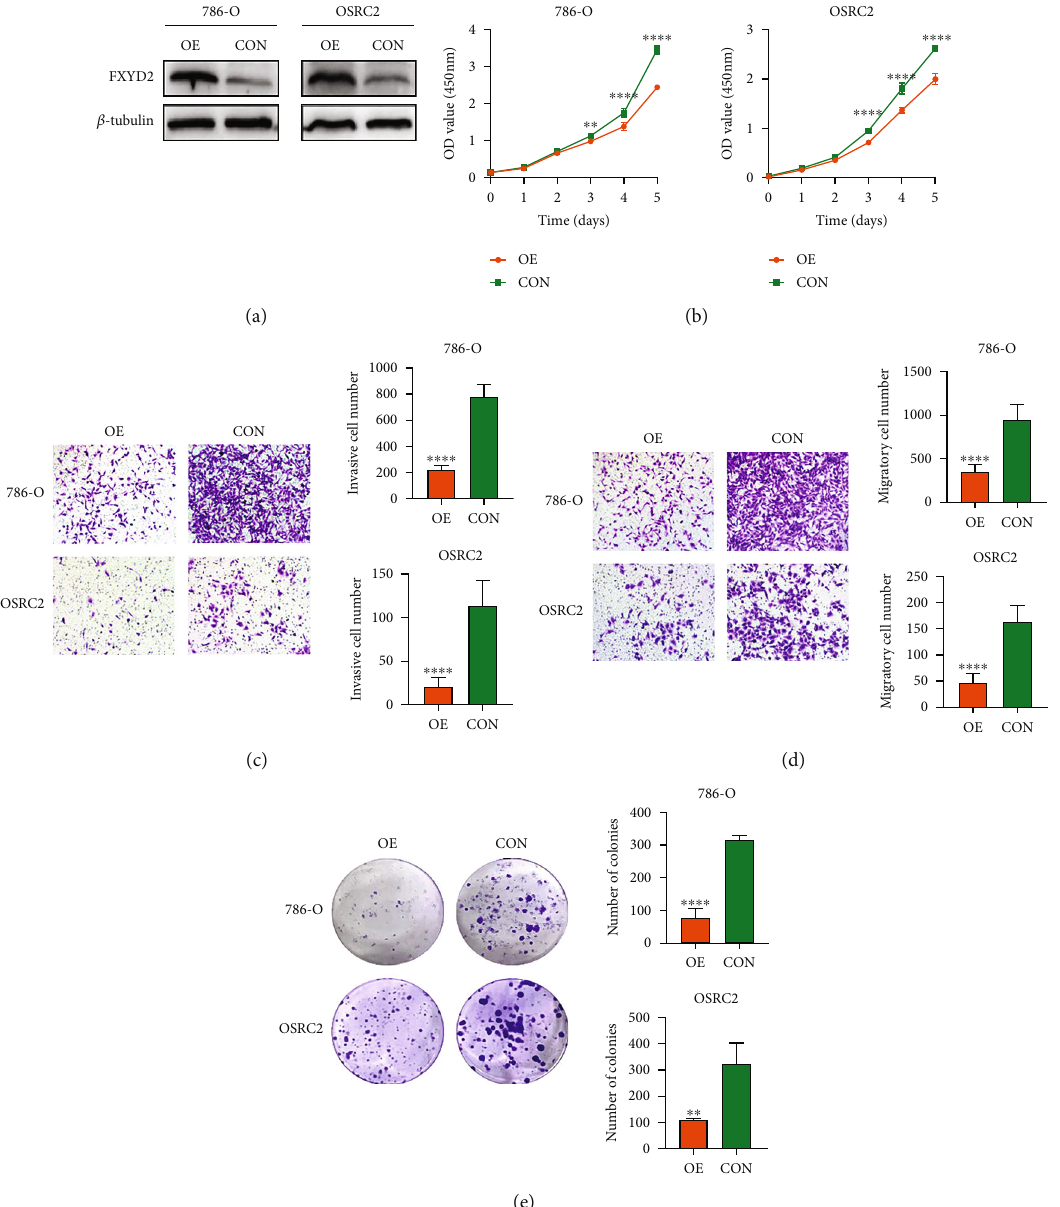
Figure 7: Overexpression of FXYD2 protein suppresses ccRCC cell proliferation, migration, and invasion in vitro. (a) The e ffi ciency of FXYD2 protein overexpression was determined by WB in 786-O and OSRC2 cells. (b – e) The cell proliferation assay, migration assay, invasion assay, and colony formation assay showed that FXYD2 overexpression suppresses cell proliferation, migration, and invasion. ccRCC: clear cell renal cell carcinoma; WB: western blot; ∗ P < 0 : 05 , ∗∗ P < 0 : 01 , ∗∗∗ P < 0 : 001 , and ∗∗∗∗ P < 0 : 0001